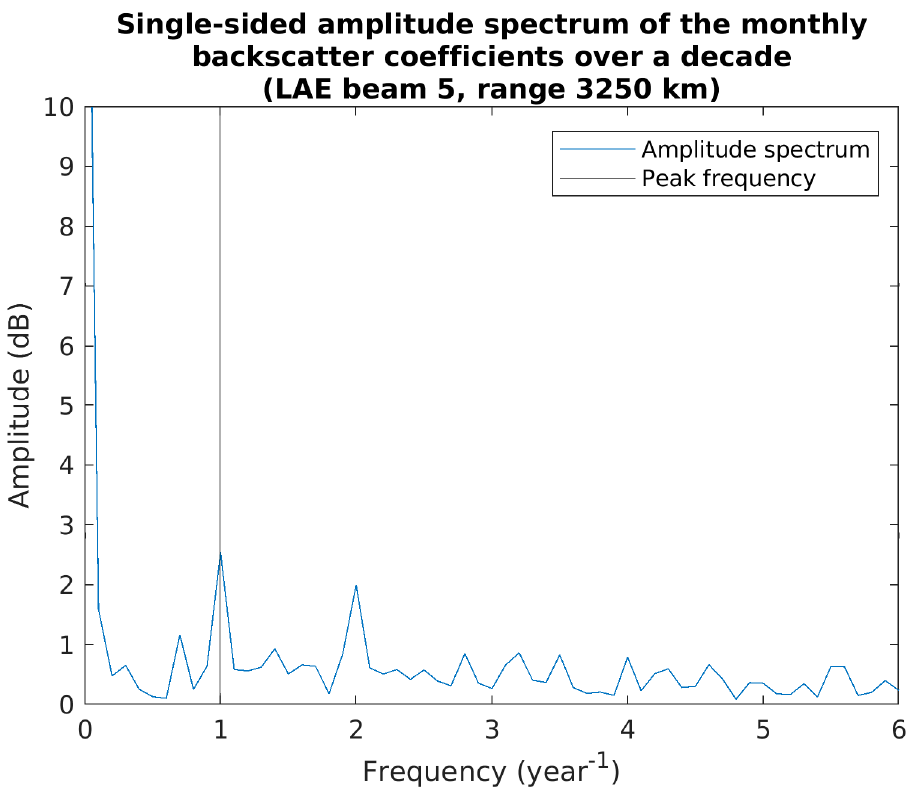
Figure 21. Single-sided amplitude spectrum from the FFT on the LAE beam 5, range 3250 km data.